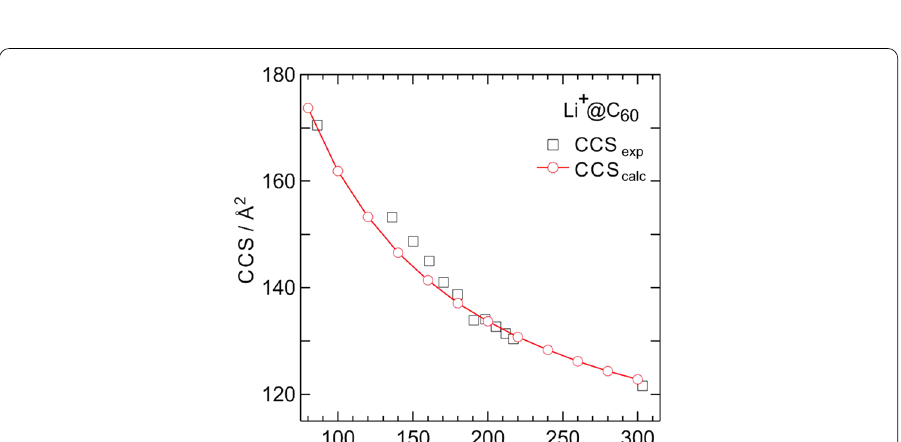
condition, the effective temperature is T eff = 86.17 K. The ATD was fitted with a Gaussian function, and the experimental CCS at 86 K ( DT CCS He,86 ) of Li + @C 60 was determined to be 170.5 ± 0.2 Å 2 from the Gaussian peak. The error was estimated from the six inde- Li + @C 60 at T eff = 86.17 K, 169.6 ± 1.0 Å 2 , which was calculated by the trajectory